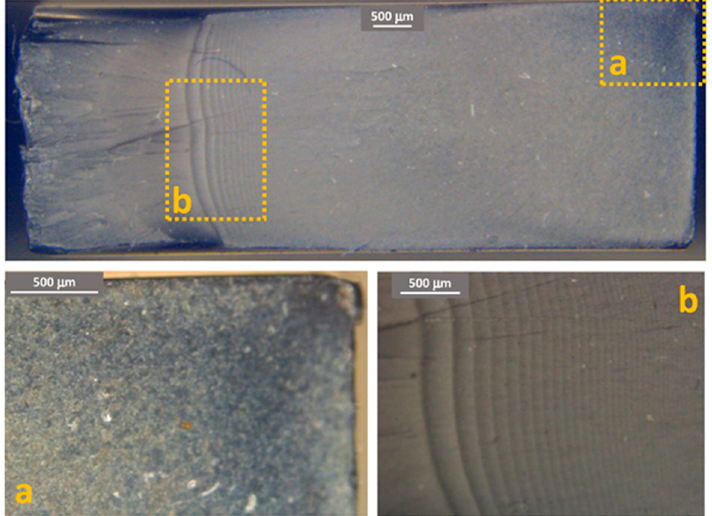
Figure 13. PC-ABS fracture surface after test at − 27 °C. ( a ) Crack initiation point; ( b ) propagation beach marks.